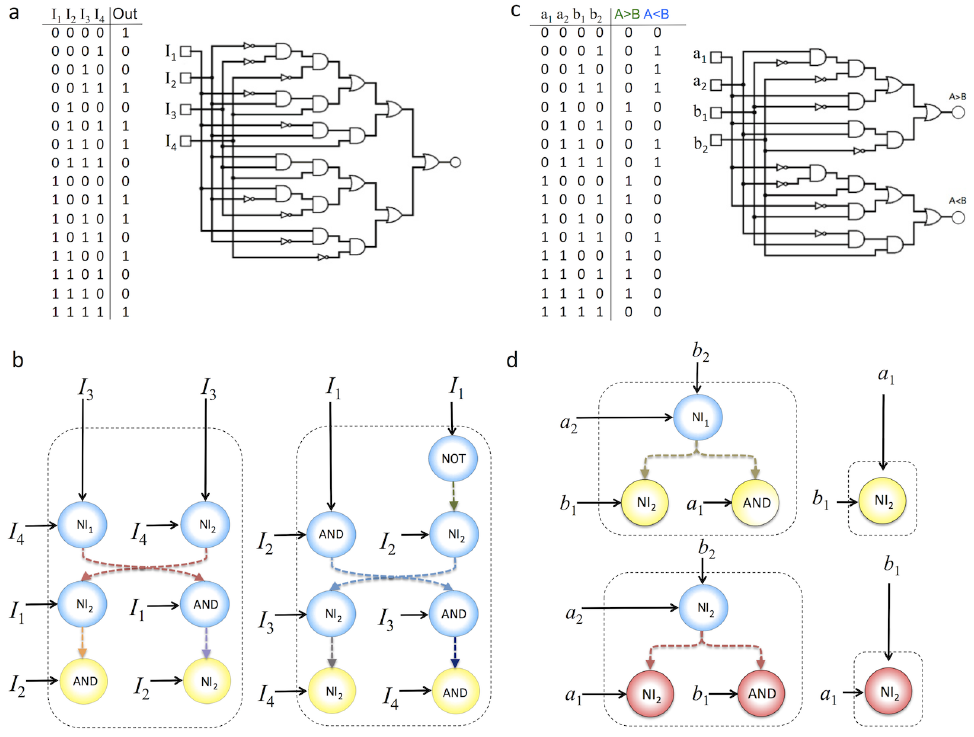
Figure 6. Scaling up DMC. In (a) we consider a complex, nontrivial 4-input 1-output Boolean function analysed in Marchisio and Stelling 2011 [57]. Figure shows the truth table and the standard design using two-input gates along with NOT gates. Below (b) we display a minimal circuit implementing this function. In (c) a two-bits comparator circuit is implemented according with the standard methodology, whereas in (d) an alternative design obtained by evolution is shown involving less gates an wires Only two communication signals (wires) are required for this implementation. Two colours (red and yellow) are used to indicate the two reporter molecules associated to each possible output (either A w B or A v B ).